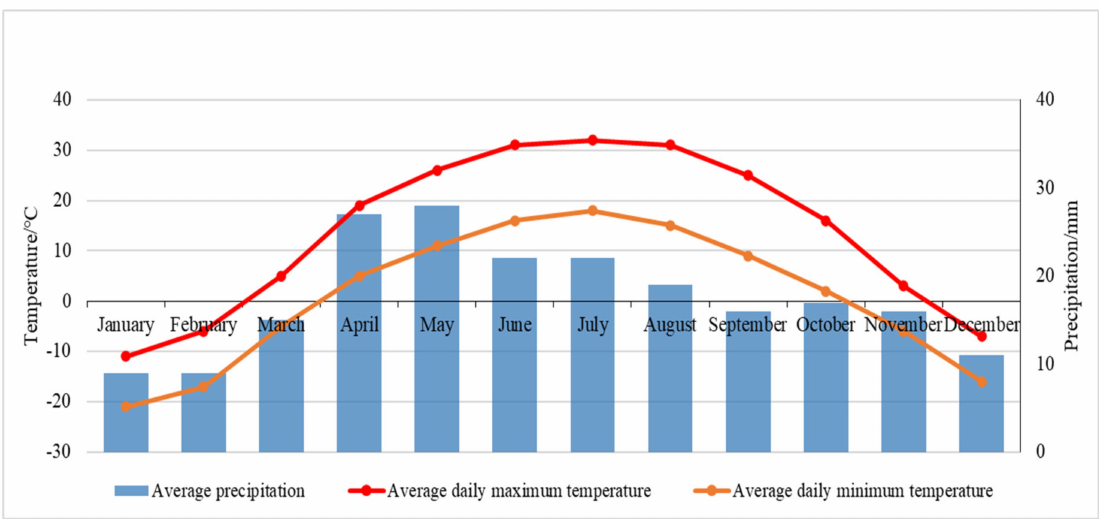
Figure 1. Average monthly precipitation and average temperatures in